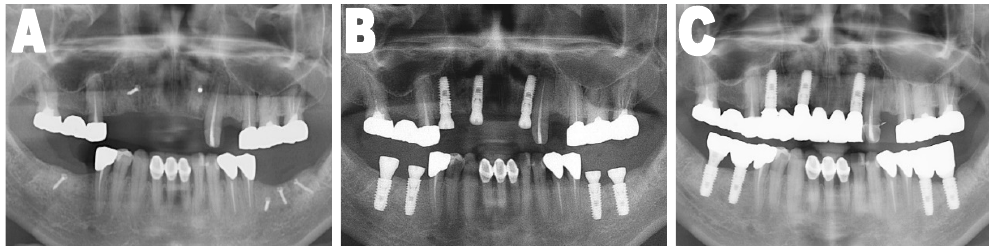
Figure 2. Orthopantomographic images. ( A ) On the day of the mandibular block bone graft; ( B ) Immediately after installation of implants; ( C ) One year after installation of the implants. Analysis between ( B , C ) orthopantomographic X-ray (OPTG) images were performed to check the number of exposed threads.